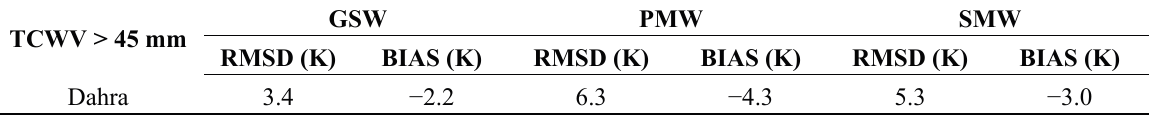
Table 4. Statistics for the comparison of LST between in situ measurements and the operational LSA SAF dataset for very moist atmospheres (TCWV > 45 mm) experienced at the KIT ‘Dahra’ station.